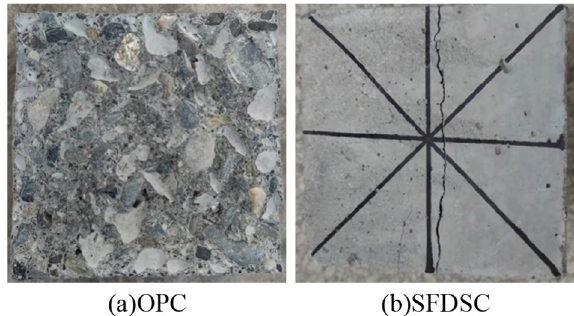
Figure 9. Photos of concrete splitting tensile strength test.